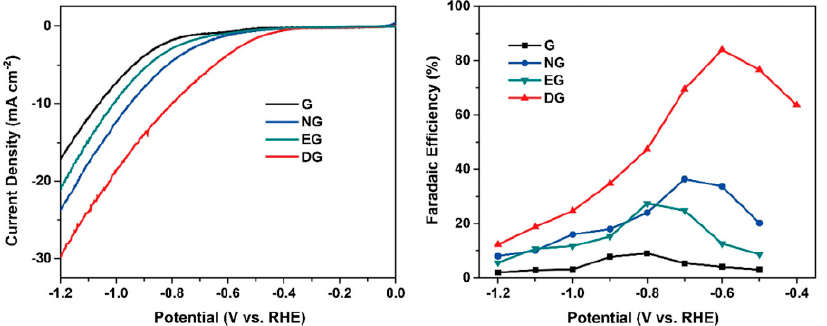
Figure 5. LSV curves in a 0.1 M KHCO 3 electrolyte (the scan rate was 10 mVs − 1 ) and faradaic efficiencies to CO at different applied potentials on pristine graphene, nitrogen-doped graphene (NG), edge-rich graphene (EG), and defective graphene (DG). Reproduced with permission [7]. Furthermore, the DG electrocatalyst was relatively stable after 10 h of the continuous ECO 2 RR at − 0.6 V (vs. RHE) (Figure 6a). In addition, Figure 6b reveals the operating 139 mV·dec − 1 was obtained for DG, which indicates the initial electronic transfer to the adsorbed CO 2 molecule to form the intermediate CO 2• − as the rate-determining step (RDS). The rest of the catalysts showed higher Tafel slope values that indicated the slower kinetics for the RDS [7].